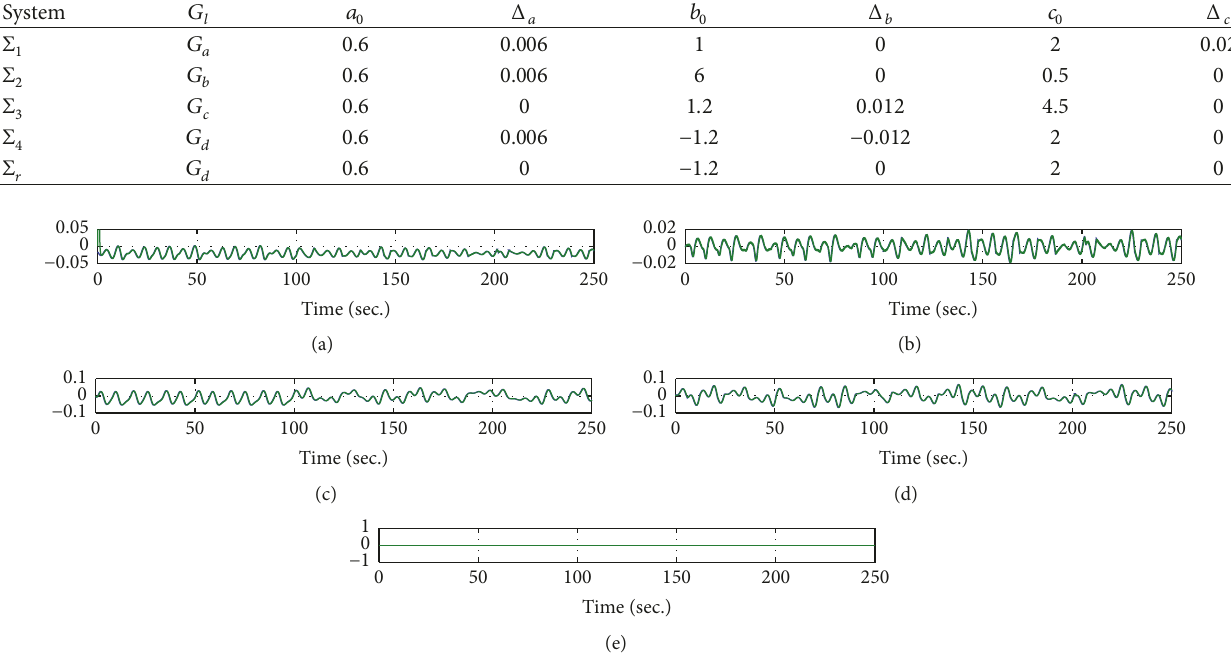
Figure 2: Actual and estimated disturbances in each node and reference system.